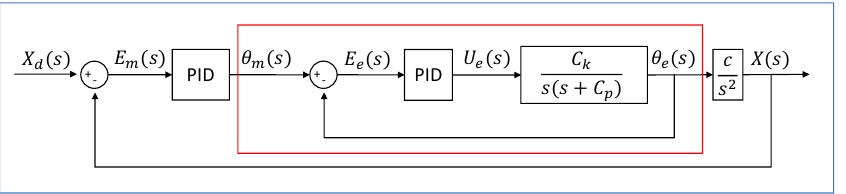
Figure 12. Ball and beam system block diagram. The blue box encloses the master control loop, whereas the red has the slave control